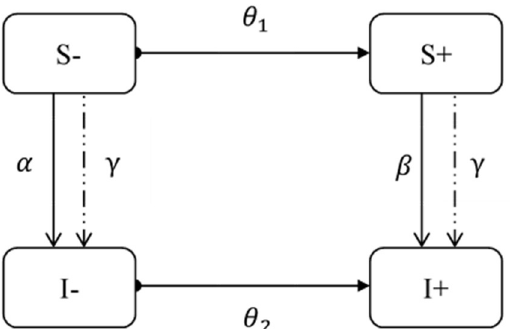
Figure 3. The process of information diffusion and COVID-19 transmission. The population is di- vided into four states: (1) 𝑆 − : unconscious susceptible; (2) 𝑆 + : conscious susceptible; (3) 𝐼 − : un- conscious infected; (4) 𝐼 + : conscious infected. 𝜃 (cid:2869) , 𝜃 (cid:2870) , 𝛼 and 𝛽 denote the probability of state